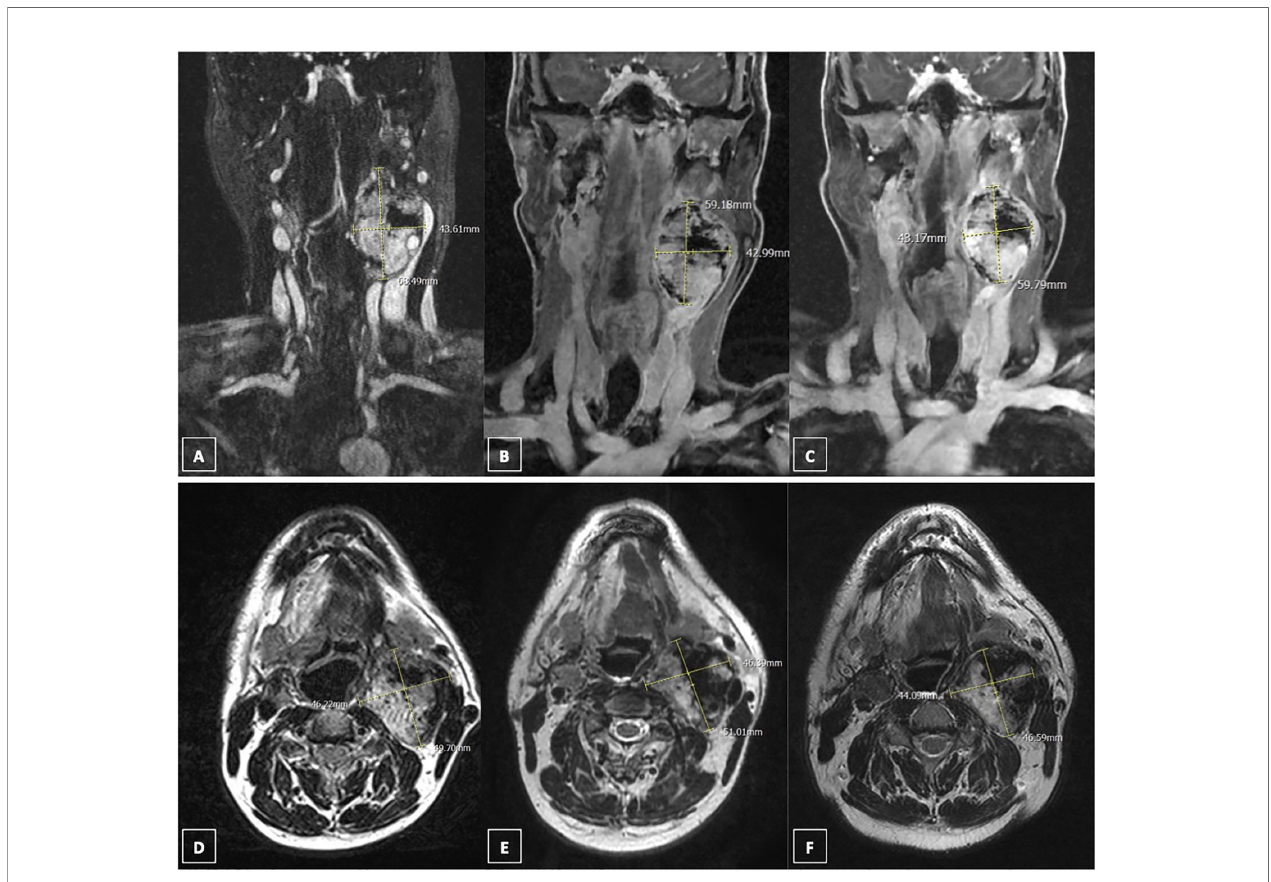
FIGURE 2 | Response to sunitinib treatment assesed by magnetic resonance (MR). (A) coronal contrast-enhanced MR scan (fat-sat T1 sequence) of left paraganglioma in April 2019; (B) coronal contrast-enhanced MR scan (fat-sat T1 sequence) of left paraganglioma in July 2020; (C) coronal contrast-enhanced MR scan (fat-sat T1 sequence) of left paraganglioma in March 2021; (D) axial contrast-enhanced MR scan (T2 sequence) of left paraganglioma in April 2019; (E) axial contrast-enhanced MR scan (T2 sequence) of left paraganglioma in July 2020; (F) axial contrast-enhanced MR scan (T2 sequence) of left paraganglioma in March